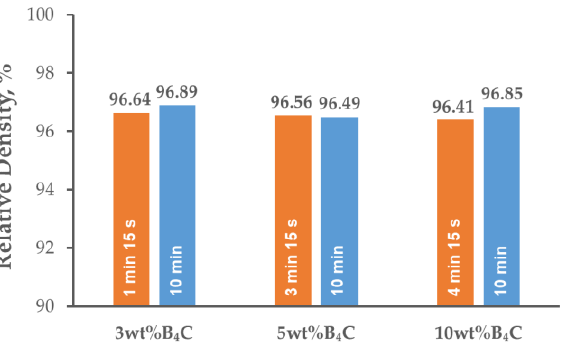
Figure 3. Relative densities of AA7075- x B 4 C ( x = 3, 5, 10 wt%) composites depending on B 4 C content and holding times.